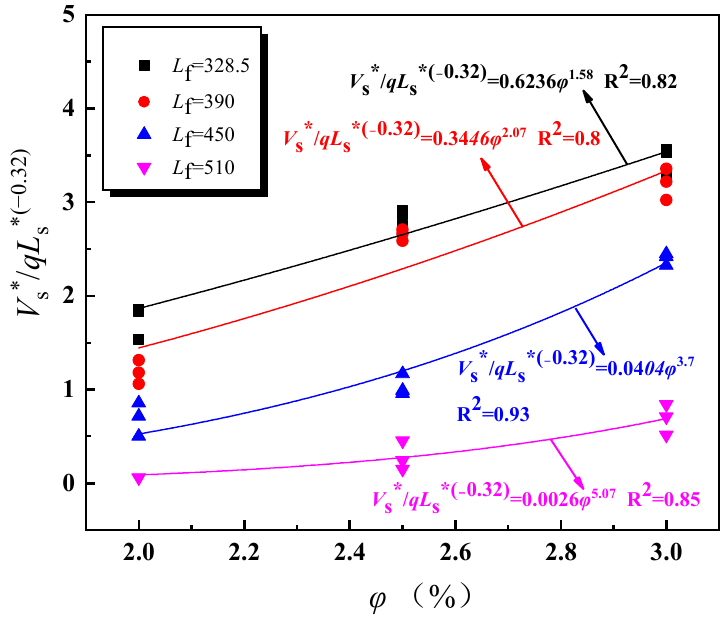
Figure 15. Dimensionless relationship between inlet air velocity at the shaft outlet and slope. The inlet air velocity at the shaft outlet changes positively as the tunnel slope increases. When the distance between fi re source and shaft gets closer, the temperature and pressure di ff erence between inside and outside the shaft is larger, and then the slope has stronger e ff ect on the inlet air velocity.